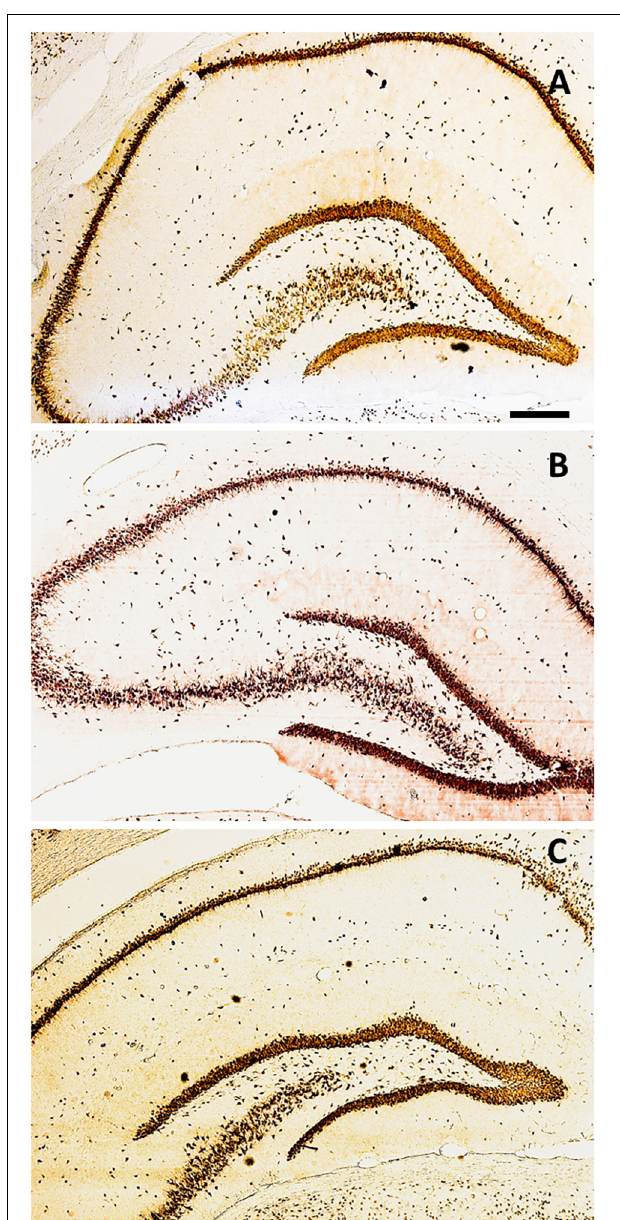
FIGURE 3 | Distribution of NeuN+ cells along with the hippocampal areas. Coronal sections immunolabeled for NeuN in the control group (Gc) (A) , G15 (B) , and G30 (C) . Scale bar = 300 µ m.